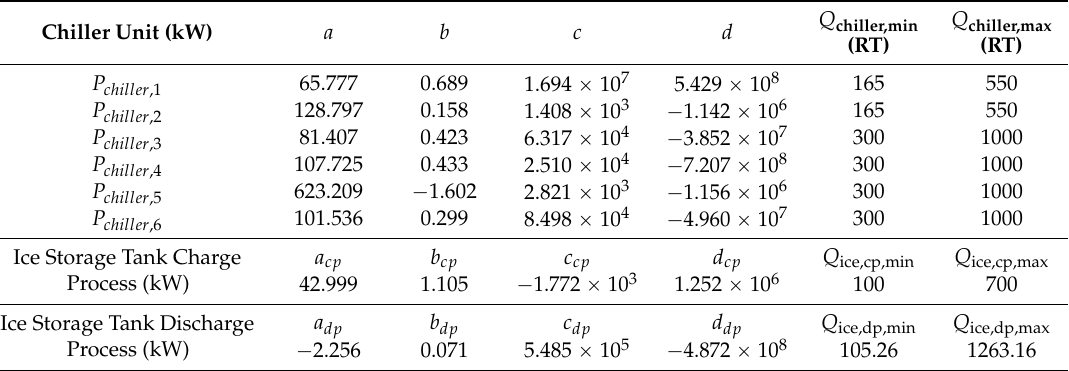
Table 3. Chillers 1 to 6 and ice storage tank.